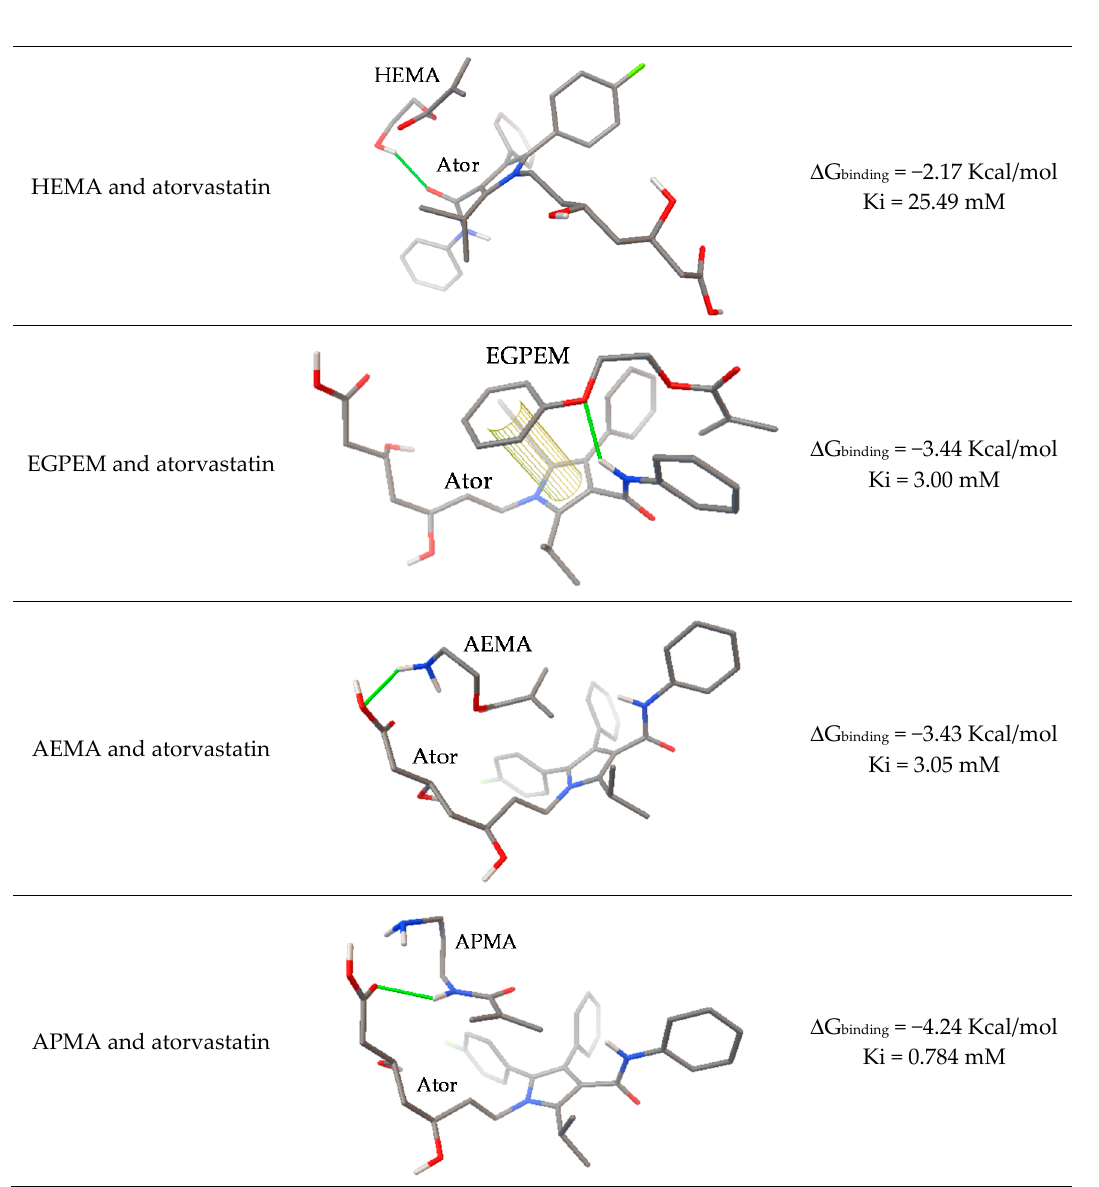
Figure 2. AutoDock modeling of structural and functional monomers–atorvastatin (Ator) interactions and the respective estimated free energy of the binding and inhibition constant. In the structures, N atoms are shown in blue, oxygen atoms in red, and the main bond interaction is shown in green.